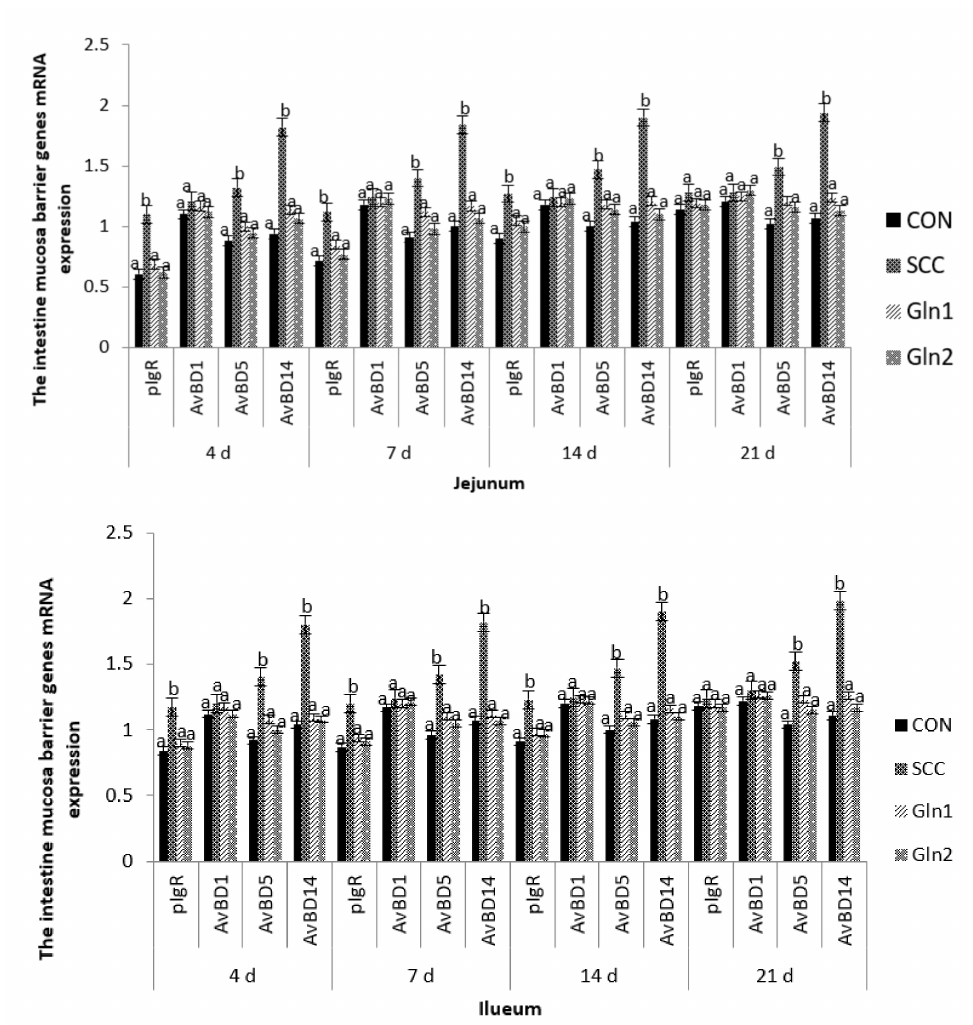
Figure 2. Effect of Gln on the jejunum and ileum mucosa barrier genes mRNA expression of broiler chickens that received S . Enteritidis. CON = a basal diet without added Gln and no challenged group, SCC = a basal diet without added Gln and received 2.0 × 10 4 CFU/mL of S. Enteritidis suspension group, Gln1 = a basal diet plus 0.5% Gln and fed 2.0 × 10 4 CFU/mL of S. Enteritidis suspension group, Gln2 = a basal diet plus 1.0% Gln and fed 2.0 × 10 4 CFU/mL of S. Enteritidis suspension group. a,b Means within a row with different superscripts are different at p < 0.05. n =